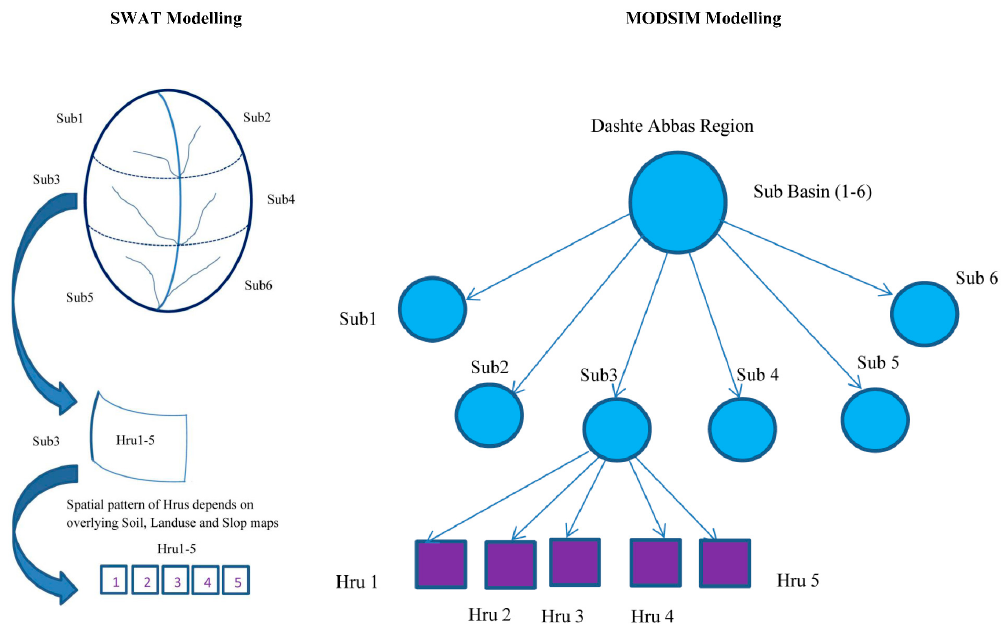
Figure 3. Overview of the input–output and information exchange in the SWAT–MODSIM (SM) model.